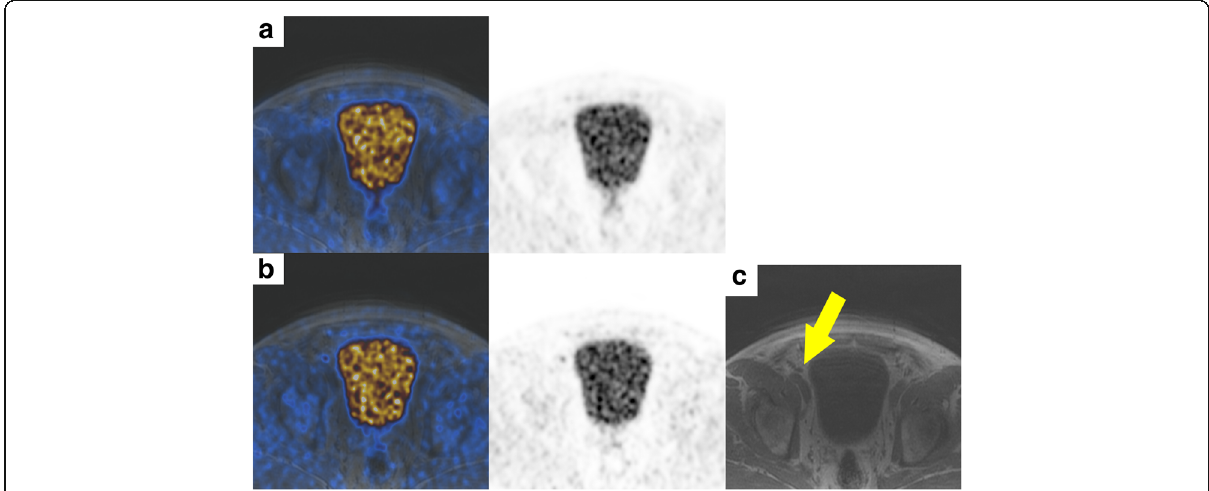
Fig. 4 Images of a patient with a PET-positive lesion along the right external iliac vessel diagnosed as a lymph node metastasis of prostate cancer. a Fusion image (left) and PET image (right) of simultaneous 18 F-choline non-TOF PET/MR. b Fusion image (left) and PET image (right) of simultaneous 18 F-choline TOF PET/MR. c T1-weighted MR image showing a normal-sized lymph node